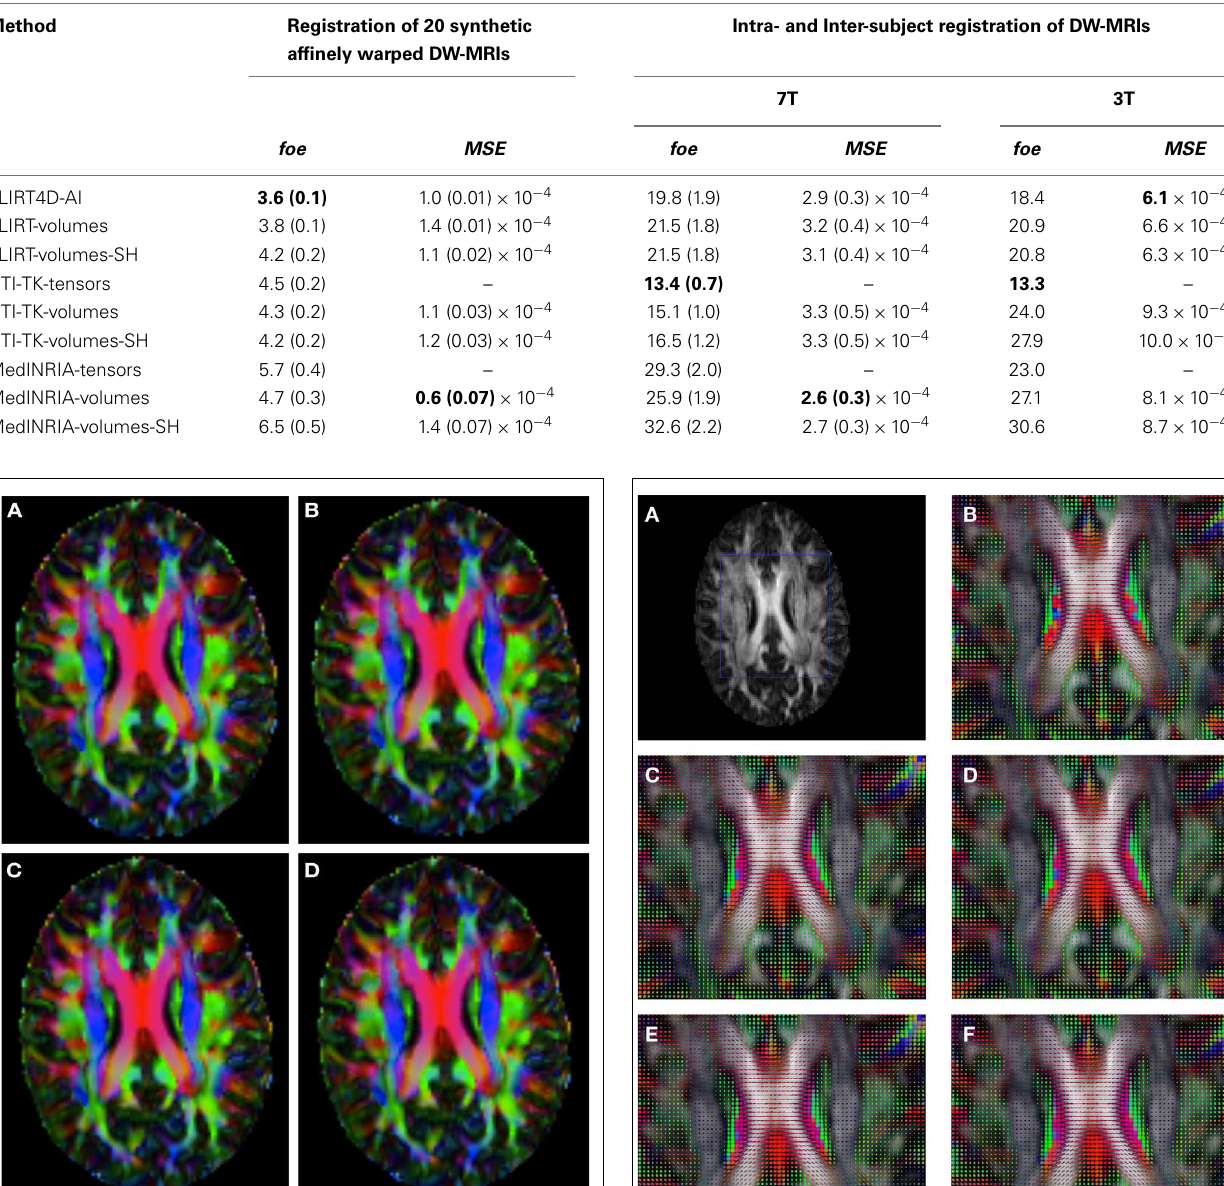
Table 3 | Non-linear registration (best results are indicated in bold).